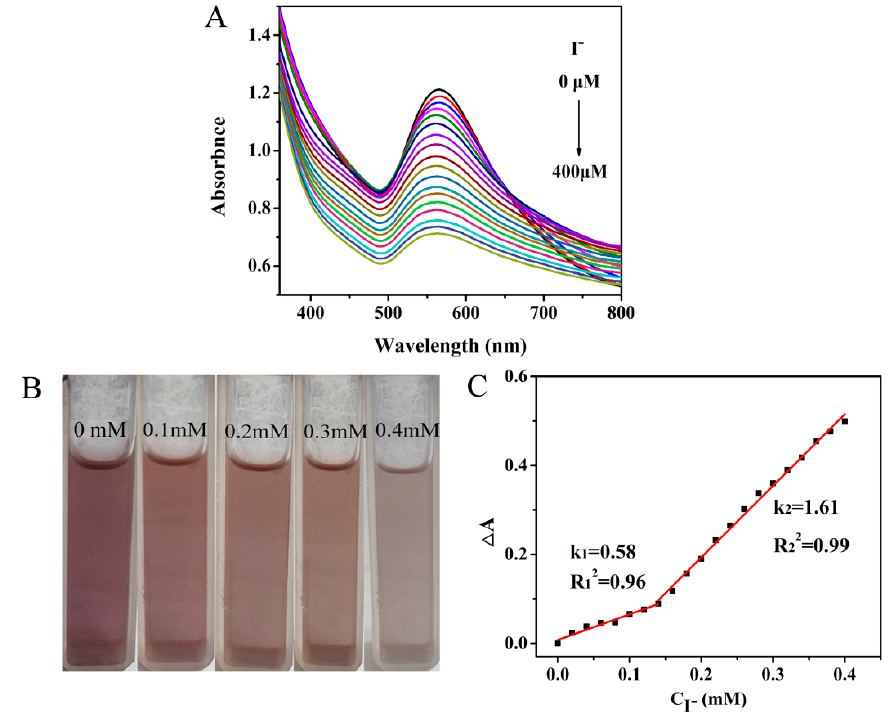
Figure 4. ( A ) UV-vis spectra of CQDs/AuNPs at different concentrations of I - (from top to bottom: 0, 20, 60, 100, 140, 160, 180, 200, 220, 240, 260, 280, 300, 320, 340, 360, 380 and 400 μ M); ( B ) Photographs of CQDs/AuNPs at different concentrations of I − (from the left to the right: 0, 0.1, 0.2, 0.3 and 0.4 mM); ( C ) Corresponding calibration curve between the relative absorption intensity Δ A and the concentrations of I − .